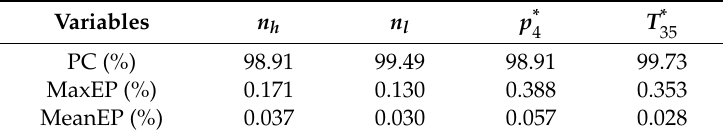
Figure 10. State responses ( a ) n h , ( b ) n l , ( c ) T ∗ and ( d ) p ∗ of the CEME model and the NCL model. 35 4 Table 1. Simulation results on training data set.